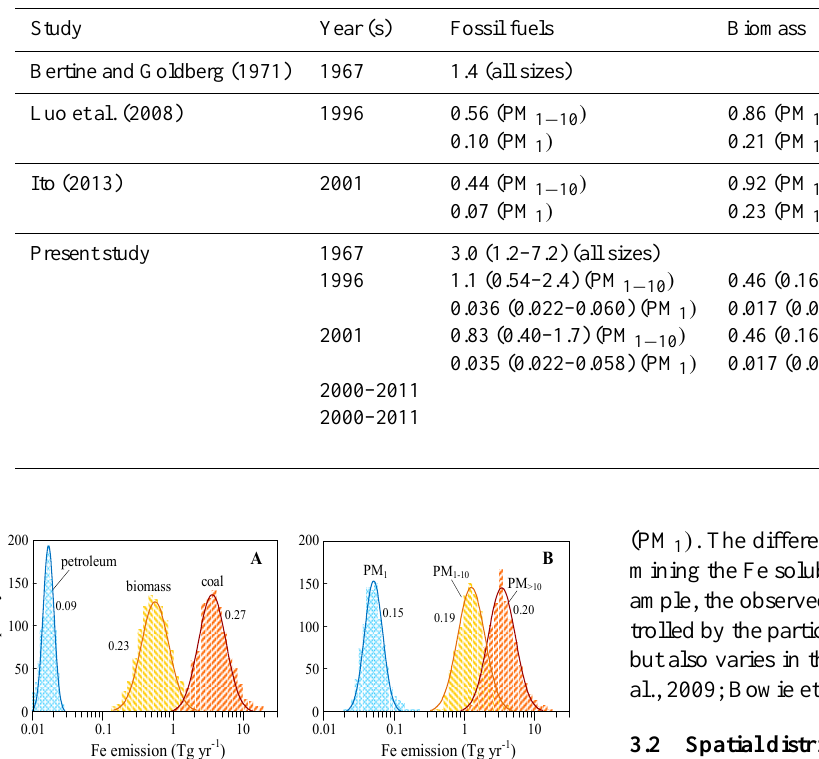
Table 2. Comparison of Fe emissions from combustion and mineral sources (Tgyr − 1 ) in the present work and previous studies. The uncer- tainty range in our estimate is given in parentheses as a 90% confidence interval from a Monte Carlo simulation (1000 runs). The Fe content of dust used to estimate Fe emissions from mineral sources ( F c ) is indicated for each estimate.